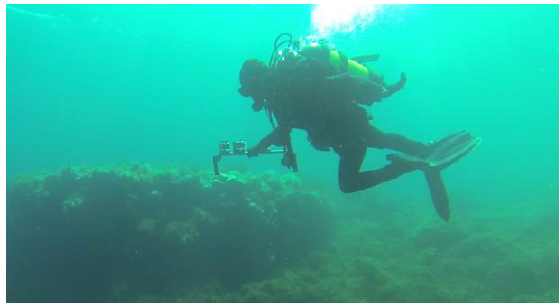
Figure 17. Roman remains of CalaGadir, Pantelleria